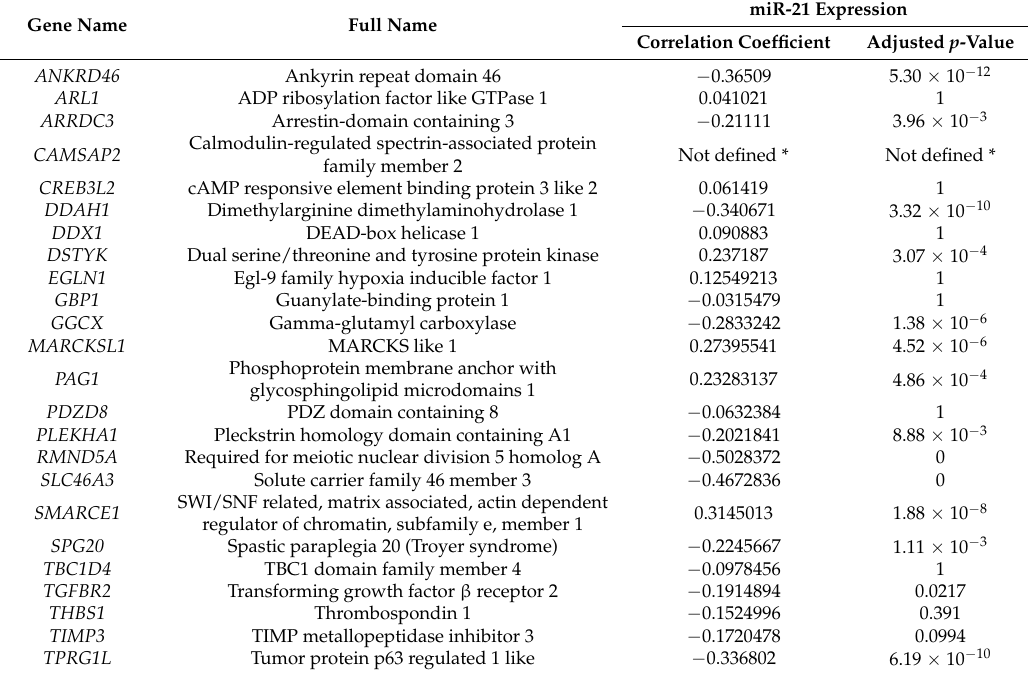
Table 1. Association between miR-21 expression and components of miR-21 interactome dysregulated after anti-sense miR-21 treatment in SK-Hep-1 cells.